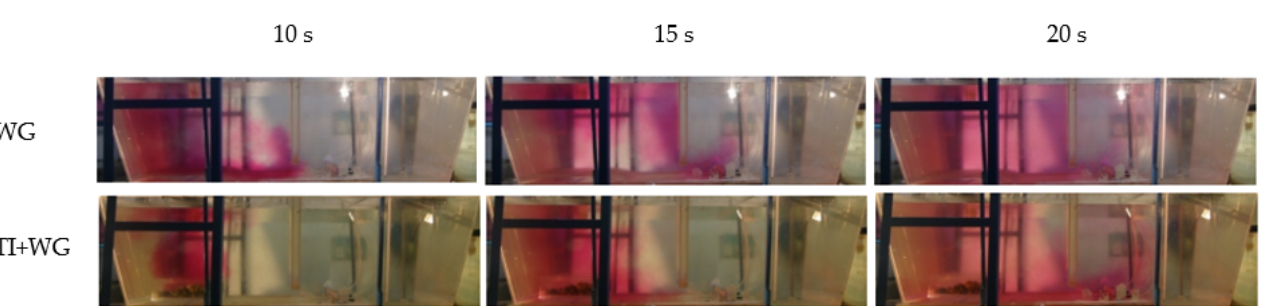
Figure 7. Tracer dispersion in cases of WG and TI + WG at 10 s, 15 s and 20 s in water experiments.